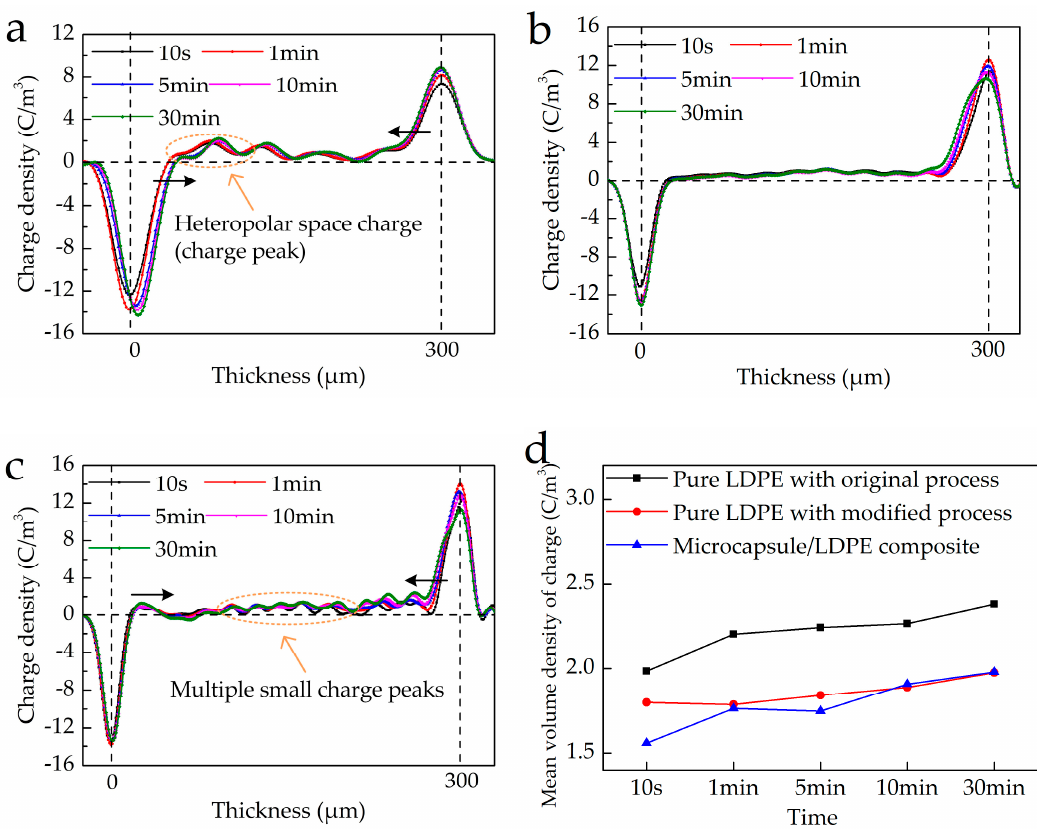
Figure 11. Space charge accumulation characteristics of polyethylene. ( a ) Pure polyethylene with the original process. ( b ) Pure polyethylene with the modified process. ( c ) Microcapsule/polyethylene composite. ( d ) Mean volume density of space charge.